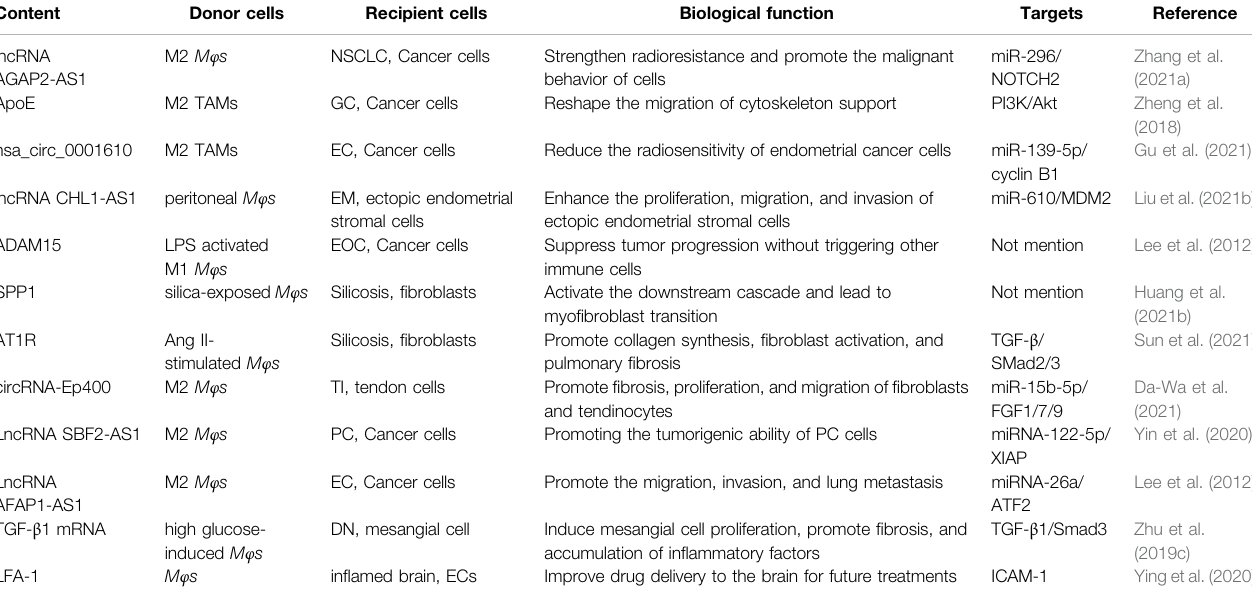
TABLE 2 | Other contents (including lncRNAs, circRNAs, proteins, mRNAs) exert different biological functions.